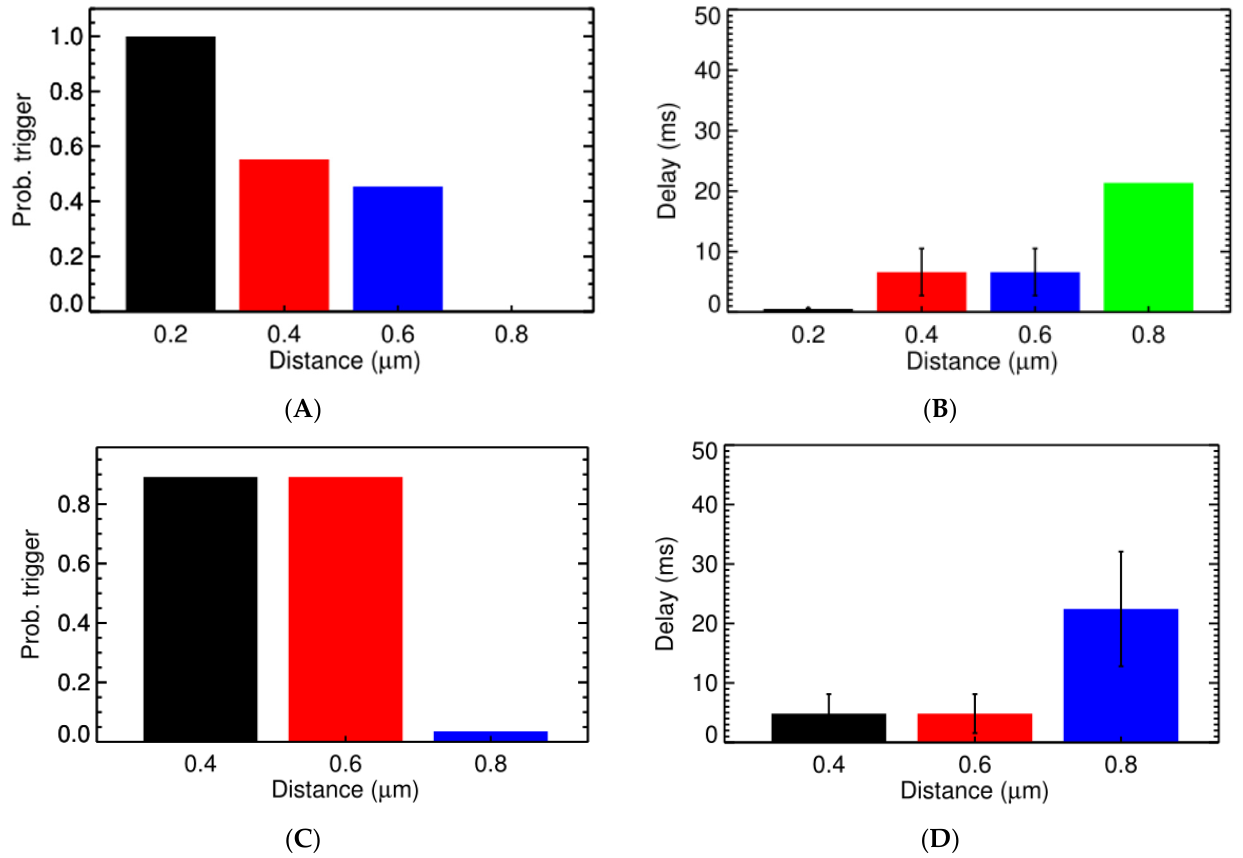
Figure 5. The probability of one CRU triggering the neighboring one at different distance and the delay. ( A ) The probability of triggering a Ca 2+ spark under normal diastolic conditions ([Ca 2+ ] myo = 0.096 µM, and [Ca 2+ ] nsr = 1.02 mM). ( B ) The Ca 2+ spark triggering delay under normal conditions. ( C ) The probability of triggering a Ca 2+ spark under high cytosolic calcium ([Ca 2+ ] myo = 0.4 µM, and [Ca 2+ ] nsr = 1.02 mM). ( D ) The Ca 2+ spark triggering delay under high cytosolic calcium.